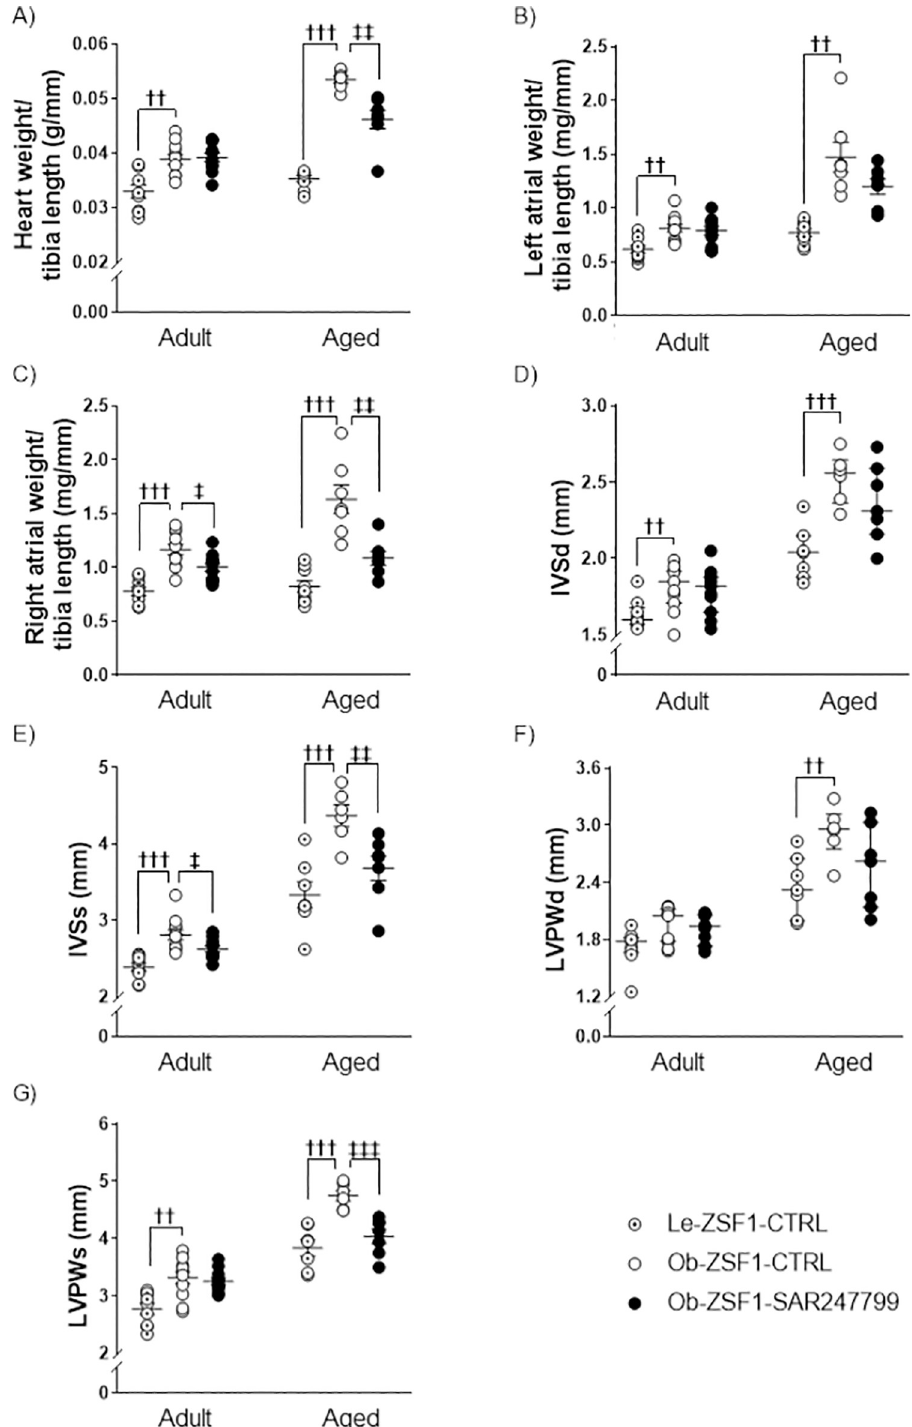
Fig 3. Cardiac hypertrophy in adult and aged ZSF1 rats after 4 weeks of treatment. (A) Heart weight/tibia length, (B) left atrial weight/tibia length, (C) right atrial weight/tibia length, (D) interventricular septum thickness at end- diastole (IVSd), (E) interventricular septum thickness at end-systole (IVSs), (F) left ventricular posterior wall thickness at end-diastole (LVPWd), (G) left ventricular posterior wall thickness at end-systole (LVPWs). Data expressed as mean ± SEM, except IVSd and LVPWd which are expressed as median ± IQR. †† p < 0.01, ††† p < 0.001: comparison of Le-ZSF1-CTRL to Ob-ZSF1-CTRL using a Student t-test, except LVPWd (adult animals) for which a Wilcoxon test